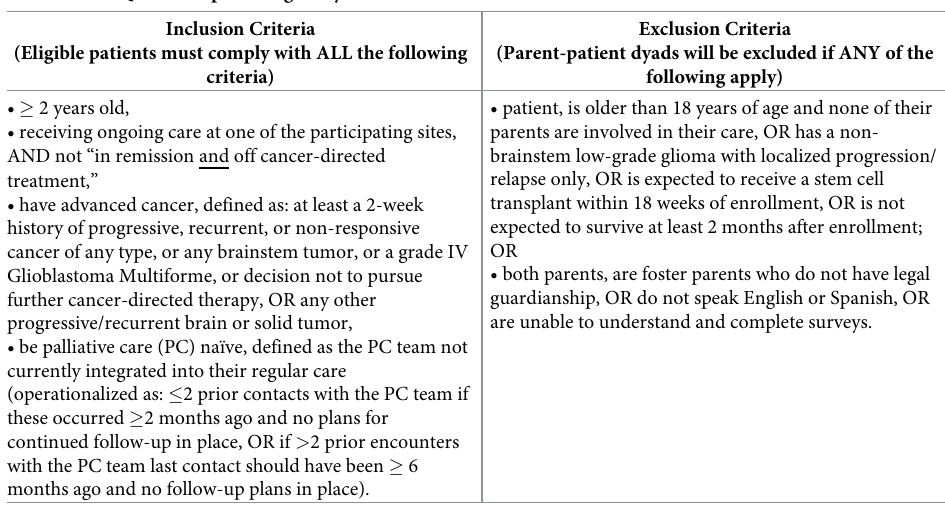
Table 1. PediQUEST response eligibility